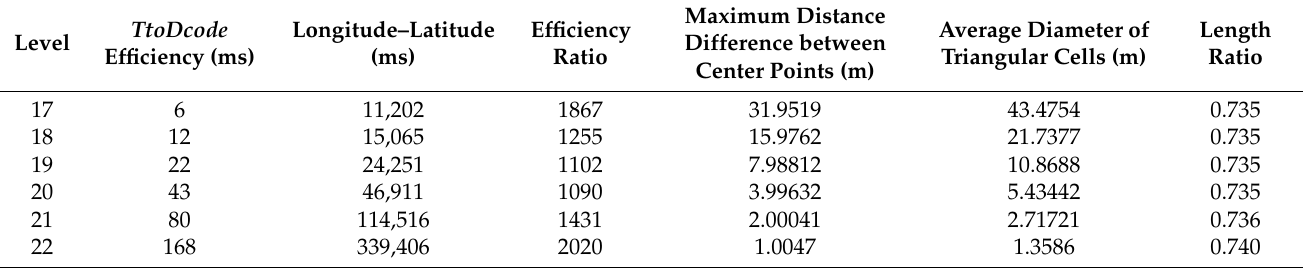
Table 19. Comparison of efficiency and accuracy of TtoDcode and longitude–latitude expressing discrete